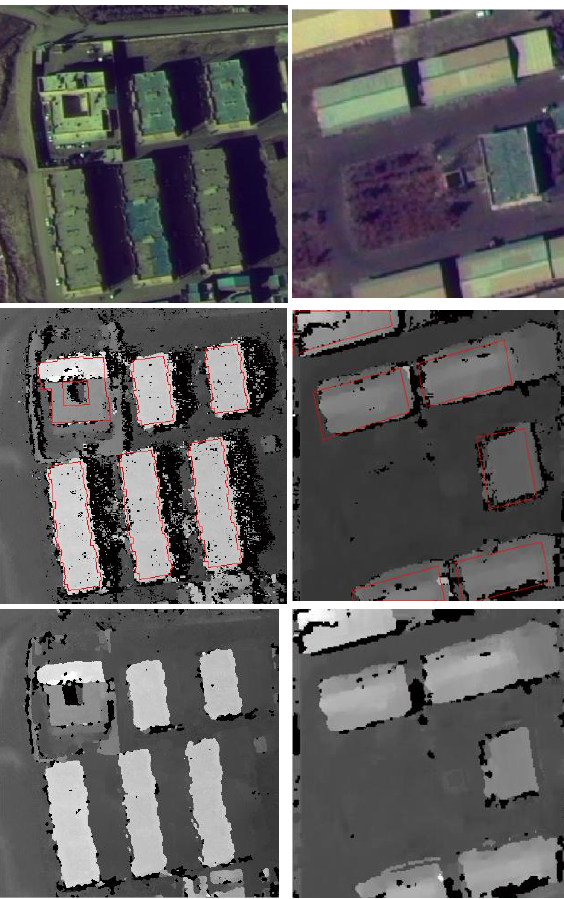
Figure 4. Shadow detection results. Top: pan-sharpened original images; middle: suspected shadow areas; bottom: overlaid object-based shadow areas on original images Cost aggregation in SGM algorithm is sensitive to entropy values and it caused a shift in disparity value of shadow areas to get closer to those of neighbouring buildings. To solve this problem, as described in section 2.3, the disparity map refinement is applied to the disparity map. The generated disparity map of SGM algorithm and enhanced disparity map are shown in Figure 5.